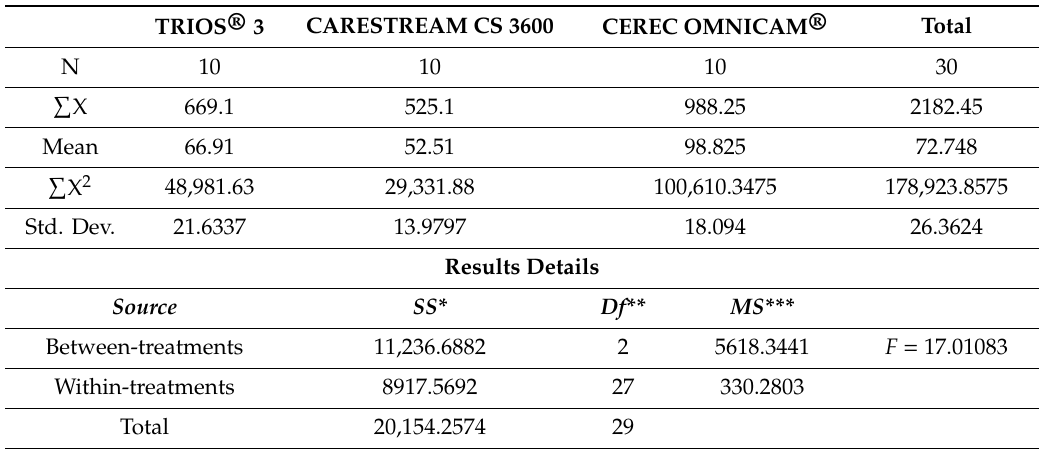
Table 6. Distance between reference lines and test ones in sample 1 without saliva. The averages are in red.